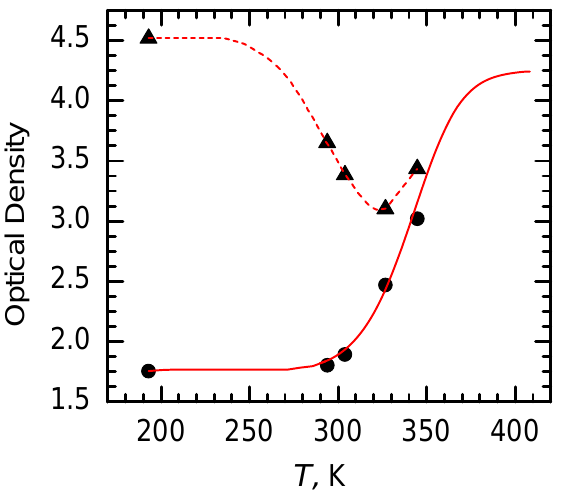
Figure 17. Temperature dependency of IR absorption at λ = 1.3 µm in CdF = 5.7 × 10 17 cm − 3 ) crystal in the dark (dark circles are experimental points; solid line ( N Ga is the result of calculation based on Figure 6 data) and under excitation of argon laser radiation (dark triangles are experimental points; dashed line shows a